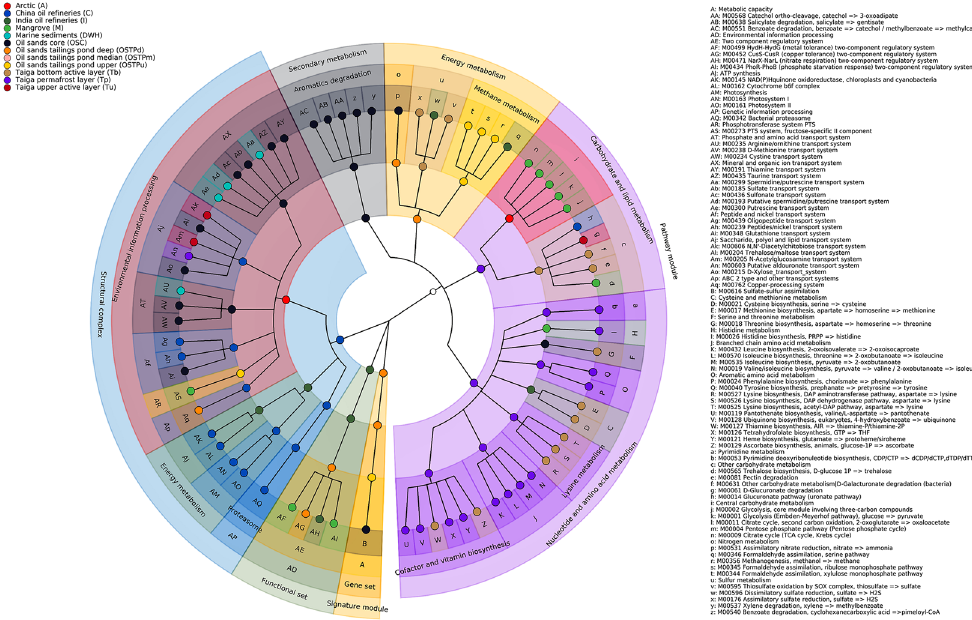
Figure 3. Metabolic reconstruction and functional biomarkers of metagenomes from oil polluted habitats. Cladogram showing a subset of the 4-level KEGG BRITE hierarchical structure denoted by four rings, as inferred against KEGG metabolic modules detected by HUMAnN2 from metagenomic gene family abundance data produced by PICRUSt for all oil contaminated samples. The outermost ring represents KEGG functional modules that have been detected in at least one of the 65 PICRUSt predicted metagenomes as reconstructed by HUMAnN2, while the innermost ring represents the Level 1 KEGG BRITE clades. Differentially abundant KEGG metabolic modules inferred by LEfSe using KEGG module abundance data generated by HUMAnN2 are colored corresponding to the oil contaminated habitat they have been identified to be differentially abundant in (see legend). Circles not differentially abundant in any habitat are colorless. Brackets represent a single KEGG BRITE clade at that Level from which daughter clades originate. KEGG BRITE clades with a single daughter clade are joined using regular branches. Annotations for the KEGG BRITE hierarchy follow an outside-in pattern, wherein Level 1 KEGG BRITE clades are annotated in the outermost section of the cladogram with lower clades annotated further inside ending at the outermost circle in that section of the cladogram. More information on this style of representation can be found elsewhere 28, 36, 83